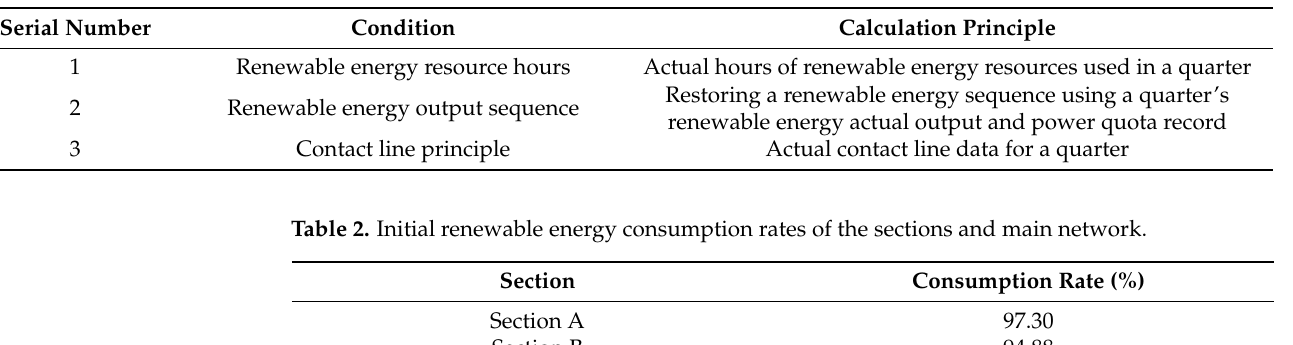
Table 1. Real conditions of the renewable energy consumption capacity.